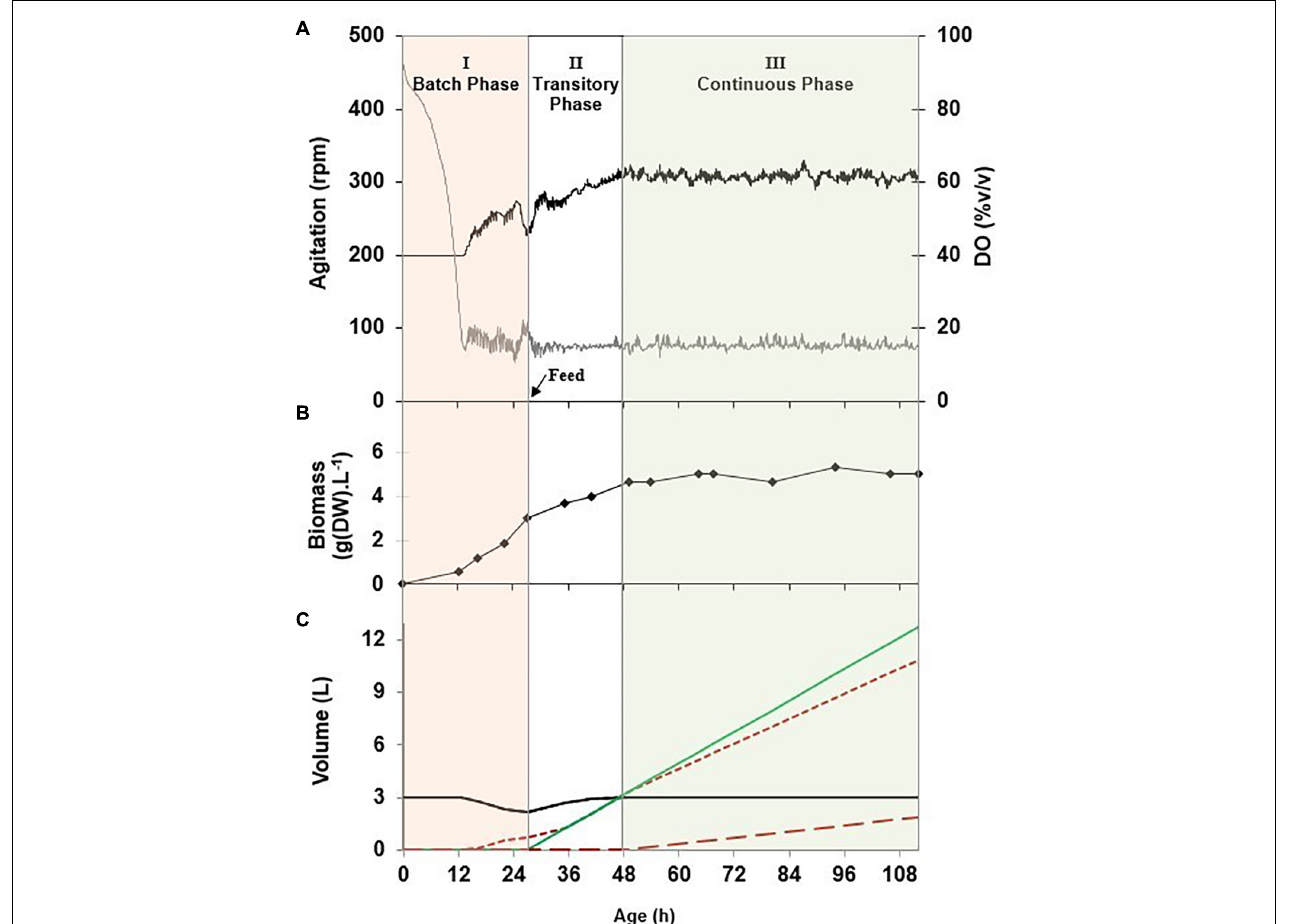
FIGURE 2 | (A) Evolution upon time of the stirrer speed ( ___ ) and the dissolved oxygen ( ___ ) during an overflowing continuous culture (O-CC) of Bacillus subtilis BBG116 in the modified Landy culture medium at a temperature of 30 ◦ C, a pH of 6.5 u · pH, a dilution rate of 0.05 h − 1 , and a dissolved oxygen value regulated above 15% v/v with an agitation cascade mode of between 200 and 400 rpm. (B) Evolution of the biomass dry weight ( (cid:7) ) in the stirred tank reactor. (C) Evolution of the volumes of the stirred tank reactor V R ( ___ ), the feed ( ___ ), the collected foam (—-), and the waste ( __ __